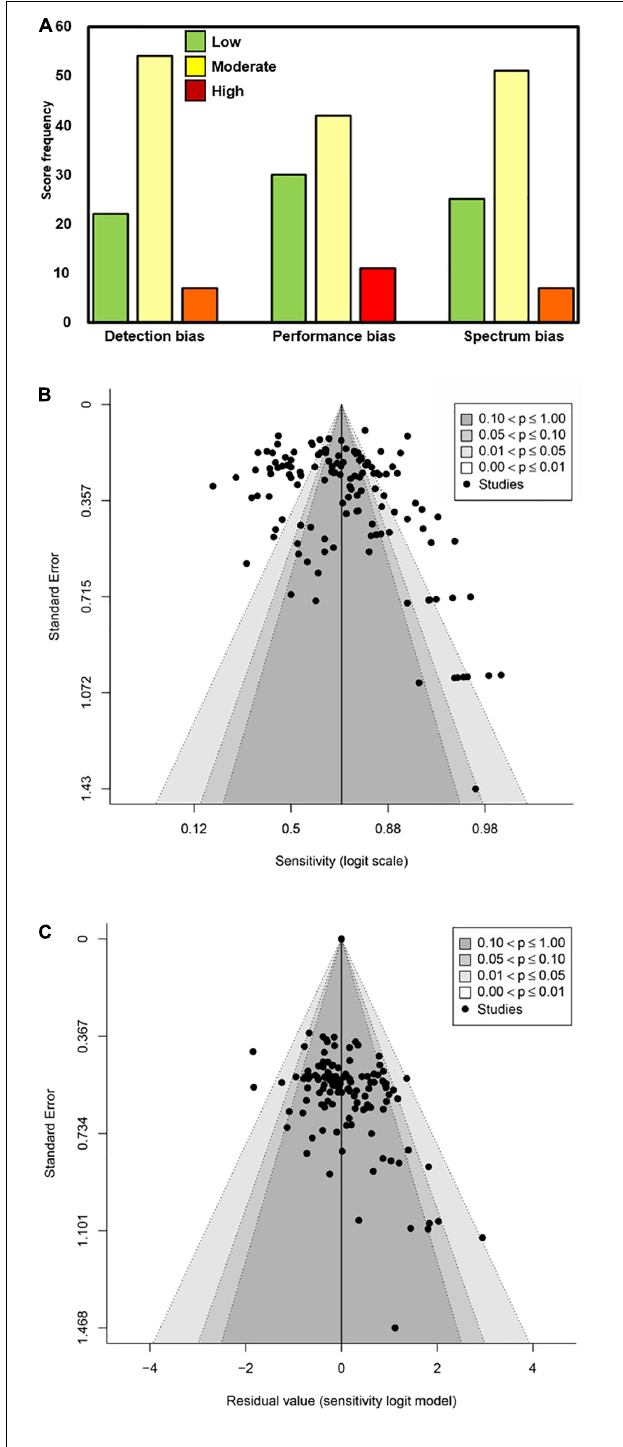
FIGURE 3 | Determination of bias associated with the source articles/documents included in this meta-analysis. (A) Scoring as Low, Moderate, and High was performed for Detection bias, Performance bias, and Spectrum bias associated with each data source included. The frequency of the scores is plotted along the Y -axis. (B,C) Funnel plots of logit-transformed sensitivity in a model without any moderators (B) and with moderators included (C)